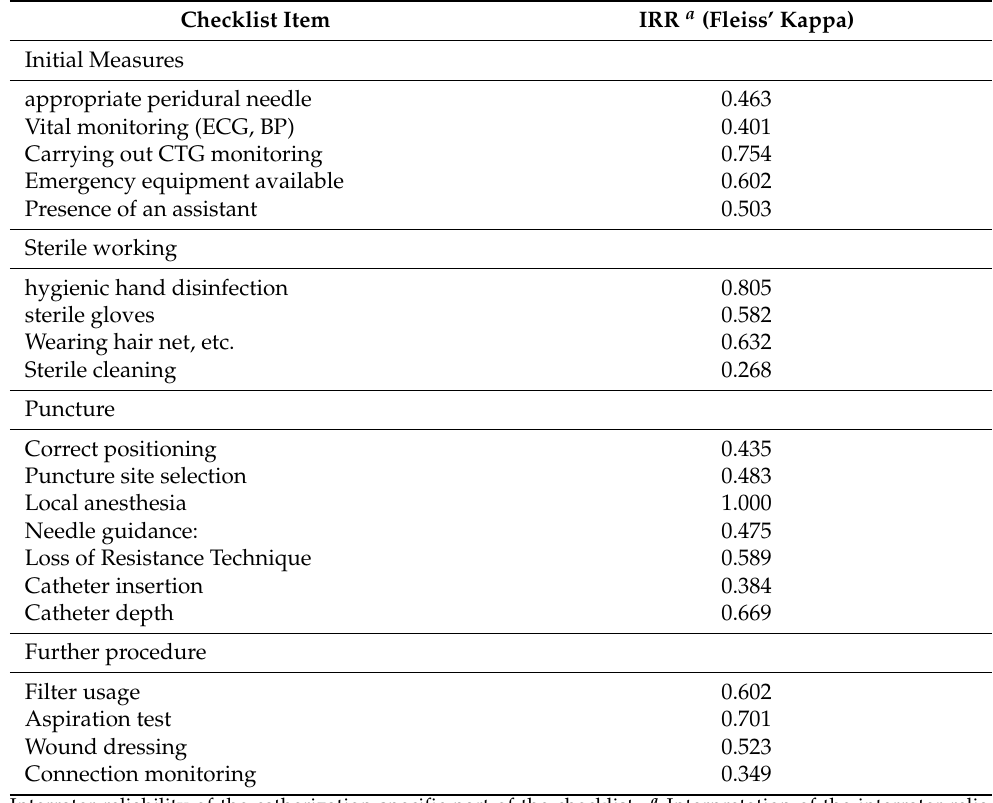
Table 3. Consistency of ratings by reviewers for skills specific items: Interrater